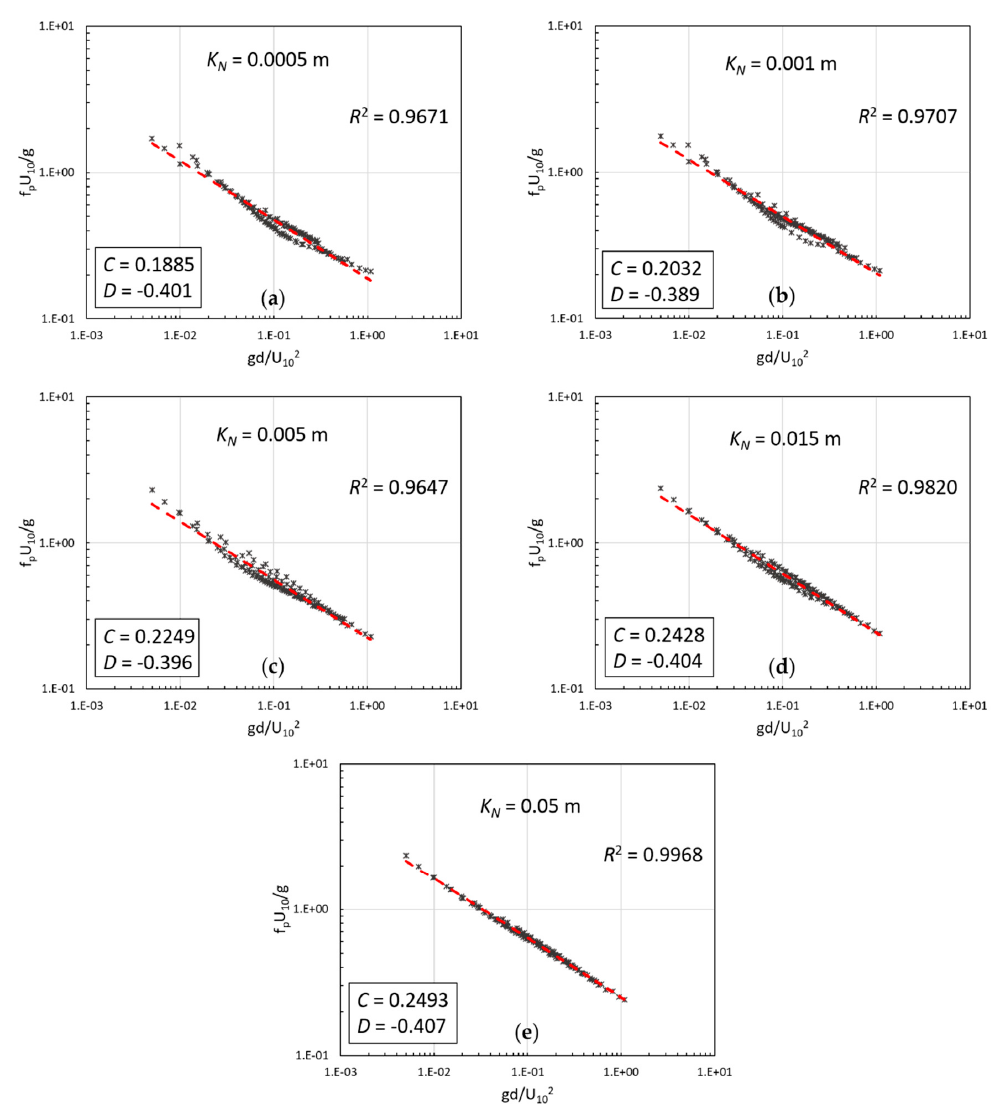
Figure 3. Dimensionless wave peak frequency grouped by different bottom roughness values: ( a ) K N = 0.0005 m; ( b ) K N = 0.0001 m; ( c ) K N = 0.005 m; ( d ) K N = 0.015 m; ( e ) K N = 0.05 m. Red dashed lines are regression curves obtained by means of the least squares method. Correlation coefficients R 2 of each linear regression are indicated on each plot. The relative coefficients C and D entering in Equation (5) are shown in the boxes.